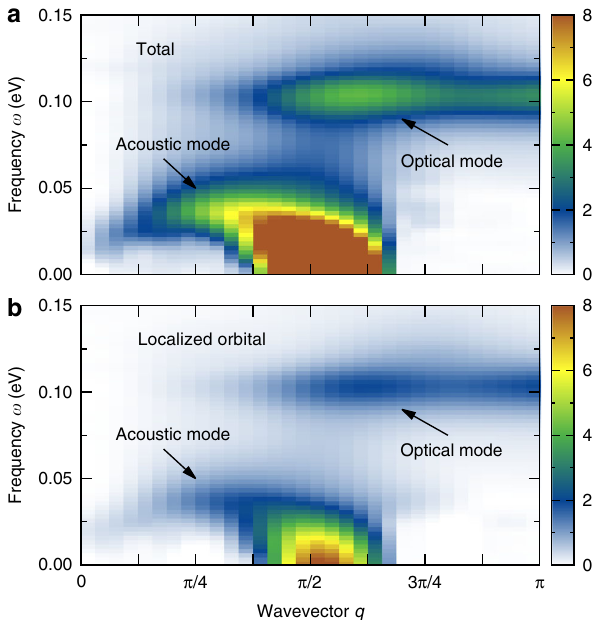
Fig. 2 Dynamical spin structure factor (SSF). a Total SSF, S ( q , ω ), and b SSF of the localized orbital, S 22 ( q , ω ). Both results exhibit a low-energy acoustic and a high-energy optical modes. Note that the spectral weight of the localized orbital, S 22 , constitutes ~50% of the total SSF weight. The results were obtained using a dynamical DMRG method with parameters L = 16 (48 orbitals), M = 800, δω = 0.005 eV, and η / δω =